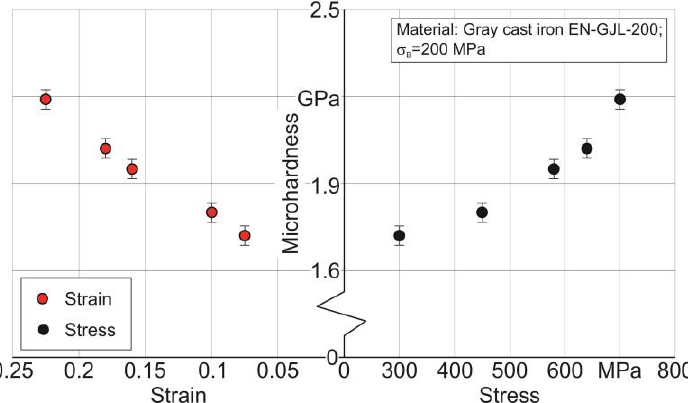
Figure 3. Correlation between the hardness of compression-tested specimens with their degree of strain and stress.